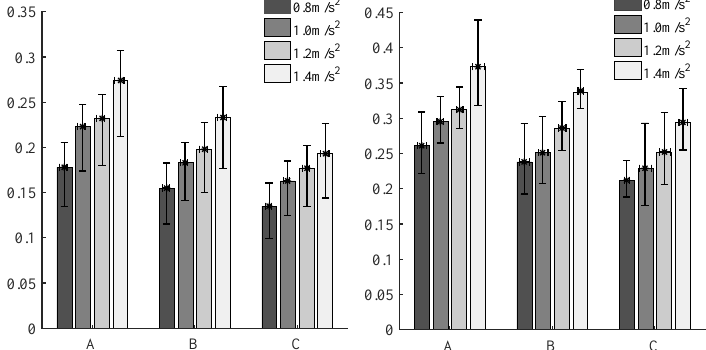
Figure 11. The muscle activation RMS value of participant one under different vehicle moving